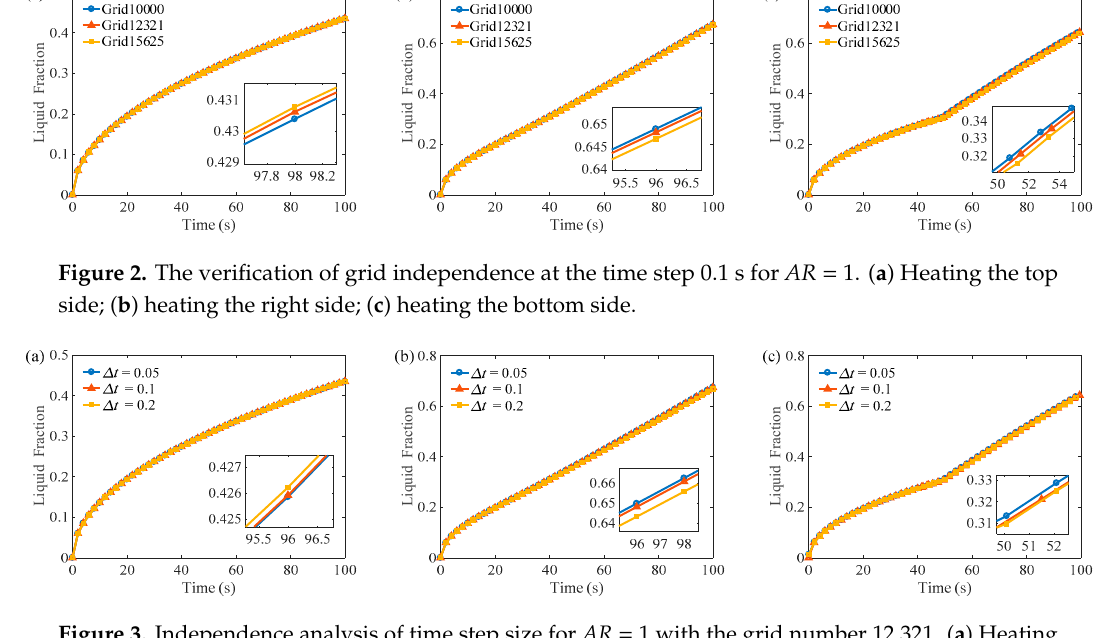
Figure 3. Independence analysis of time step size for AR = 1 with the grid number 12,321. ( a ) Heating the top side; ( b ) heating the right side; ( c ) heating the bottom side.